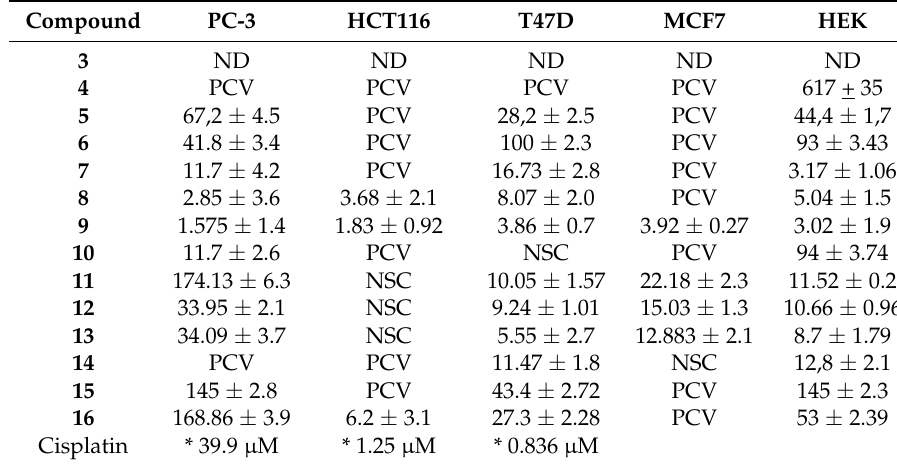
Table 1. IC 50 values ( µ M) of